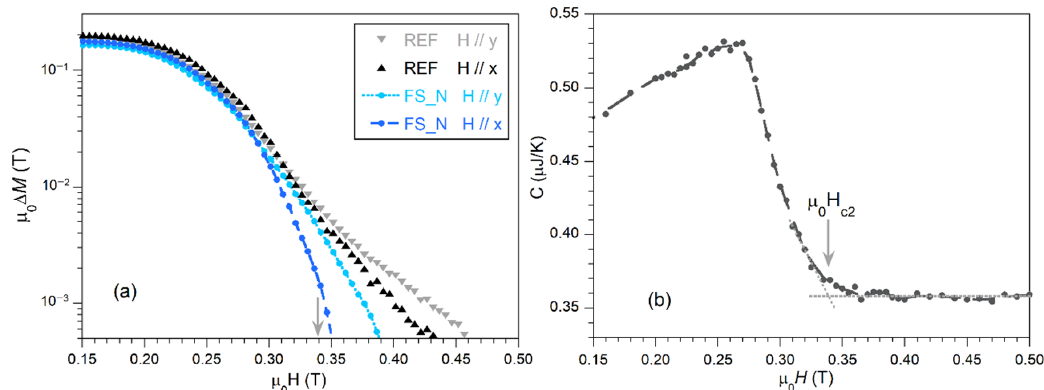
Figure 6. ( a ) Field dependence of the magnetic hysteresis loop width, µ 0 ∆ M ( H ) at T = 5 K of the REF and FS_N samples with the external DC field applied in the x - and y -directions, both parallel to the surface as indicated in Figure 1; ( b ) heat capacity of the non-irradiated reference (REF) sample recorded at 5 K. The derived upper critical field µ 0 H c2 is marked by an arrow. Both arrows point to the same magnetic field, for better comparison.